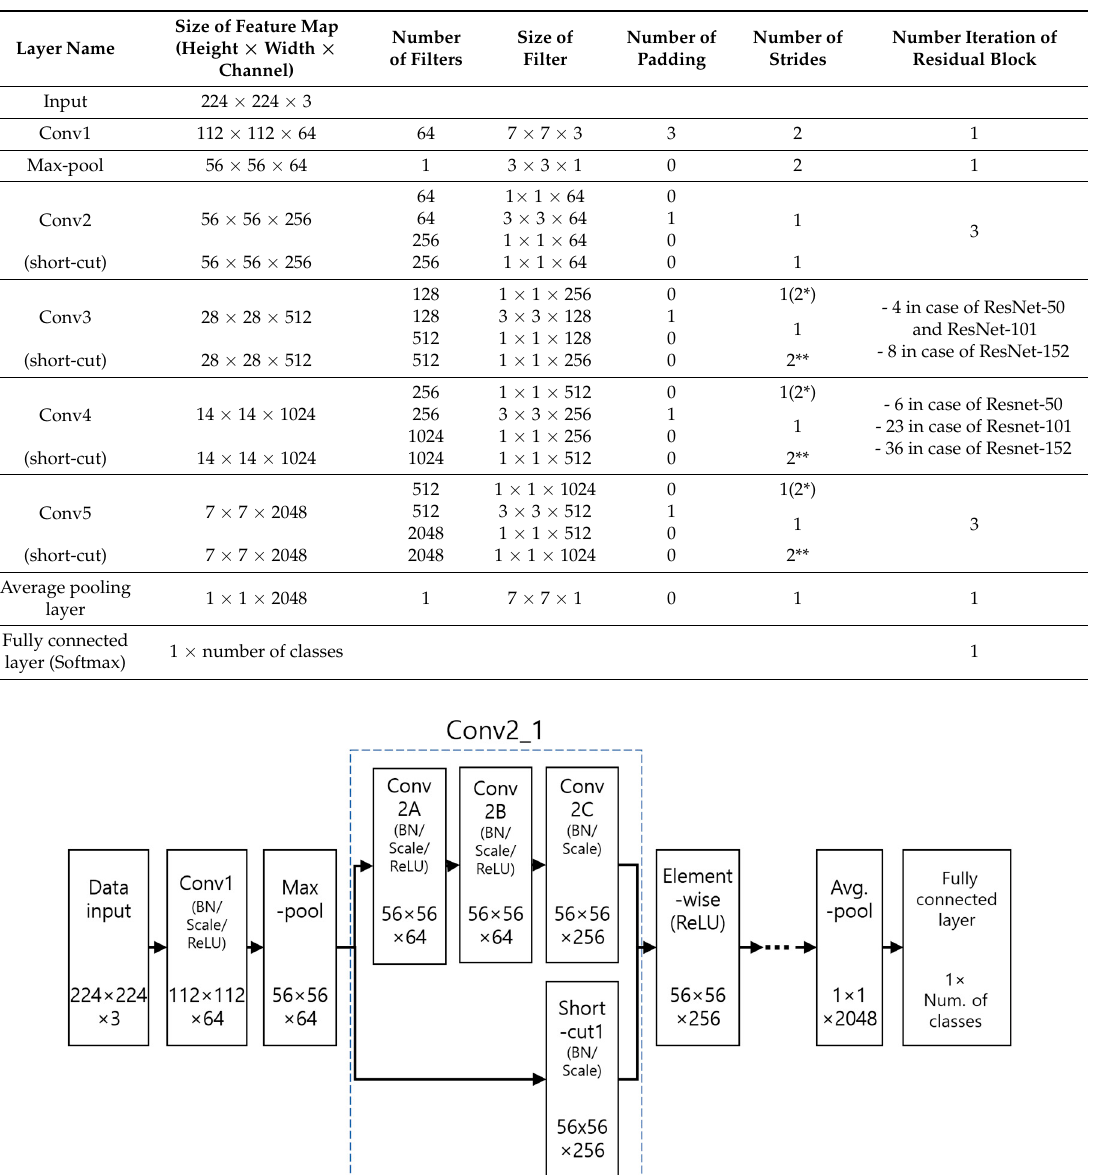
Table 2. Detailed description of each layer in our deep ResNet (1(2*) means that a stride of 2 is used only when processing each first residual block where the feature map size is reduced to half; otherwise 1 is used) (2** means that it is applied only to a 1 × 1 convolution, and it is not applied to identity mapping) (during each iteration, 1 × 1 convolution + batch normalization (BN) is performed only during the first iteration, and identity mapping is performed during the other iterations) (Conv3–Conv5 include bottleneck structures).